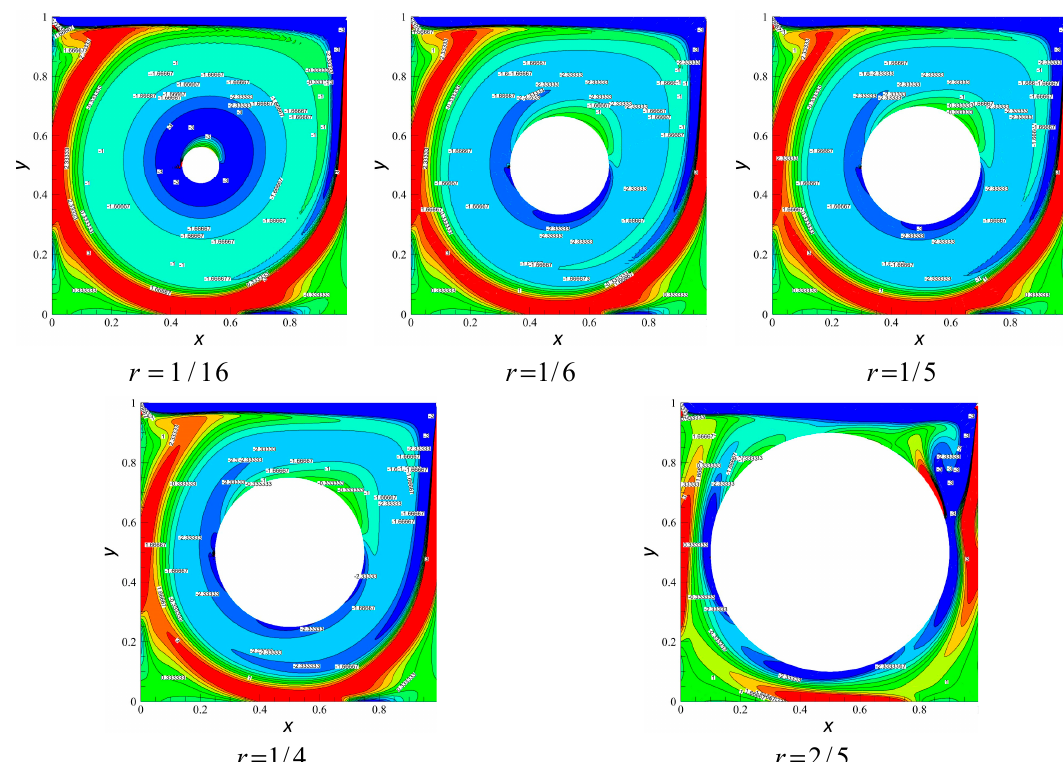
= . Figure 10. Vorticity contours for various r at Re = = .